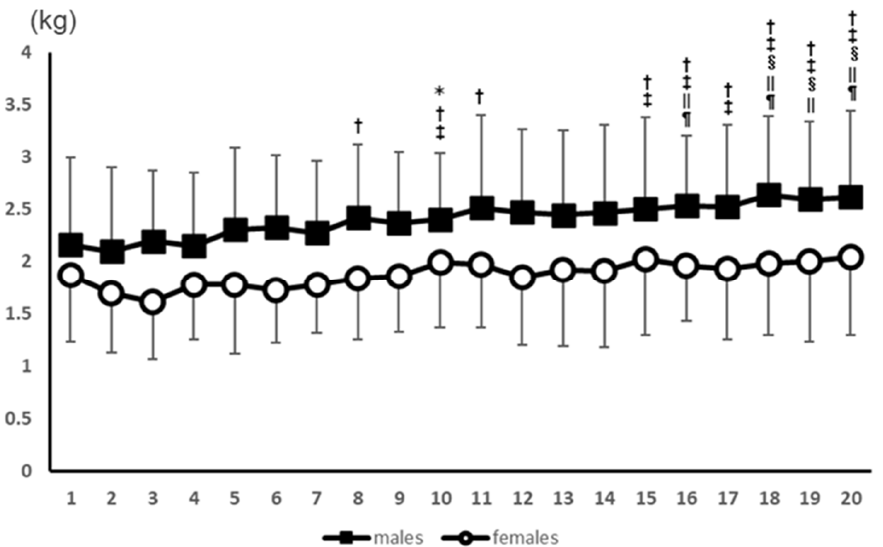
Figure 1. Results of the PPT values for the elbow flexors for 20 consecutive measurements. *: Signif- icant di ff erence from the 2nd measurement. †: Signi fi cant di ff erence from the 3rd measurement. ‡: Significant difference from the 4th measurement. §: Significant difference from the 5th measure- ment. ||: Significant difference from the 6th measurement. ¶: Significant difference from the 7th measurement.